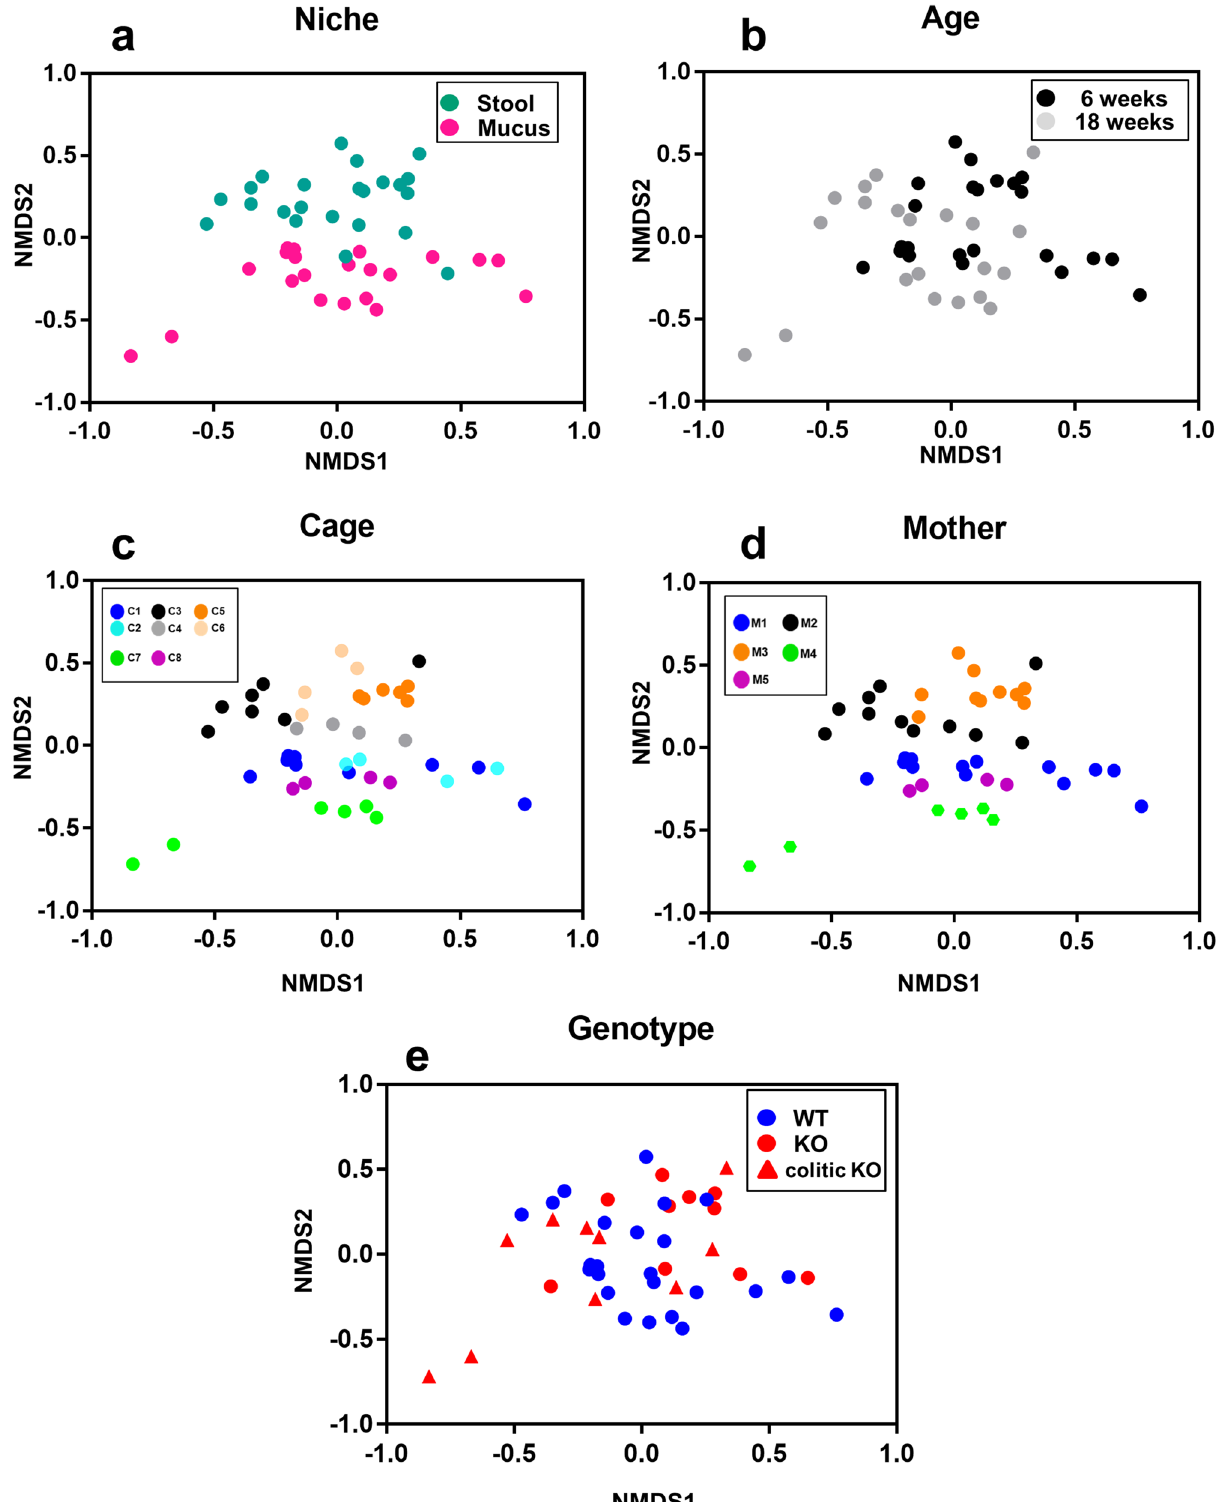
Figure 2. Separation of microbiota via NMDS for microbial niche, age, cage and mother. Two dimensional non-metric multidimensional scaling (NMDS) was performed using a Bray Curtis dissimilarity matrix based on the relative abundance of all clades in the phylogenetic tree shown in Fig. 1B. Plots highlighting stool and mucus samples ( a ), 6 and 18 week old samples ( b ), different cages ( c , C1–C8 represent cages 1–8), mothers ( d , M1–5 represent mothers 1–5) and WT (wildtype) and KO ( mdr1a −/− ) samples ( e ) are illustrated. Each point corresponds to a stool or a mucus sample. These samples were taken from n = 10 mice per genotype. Figure produced in GraphPad Prism